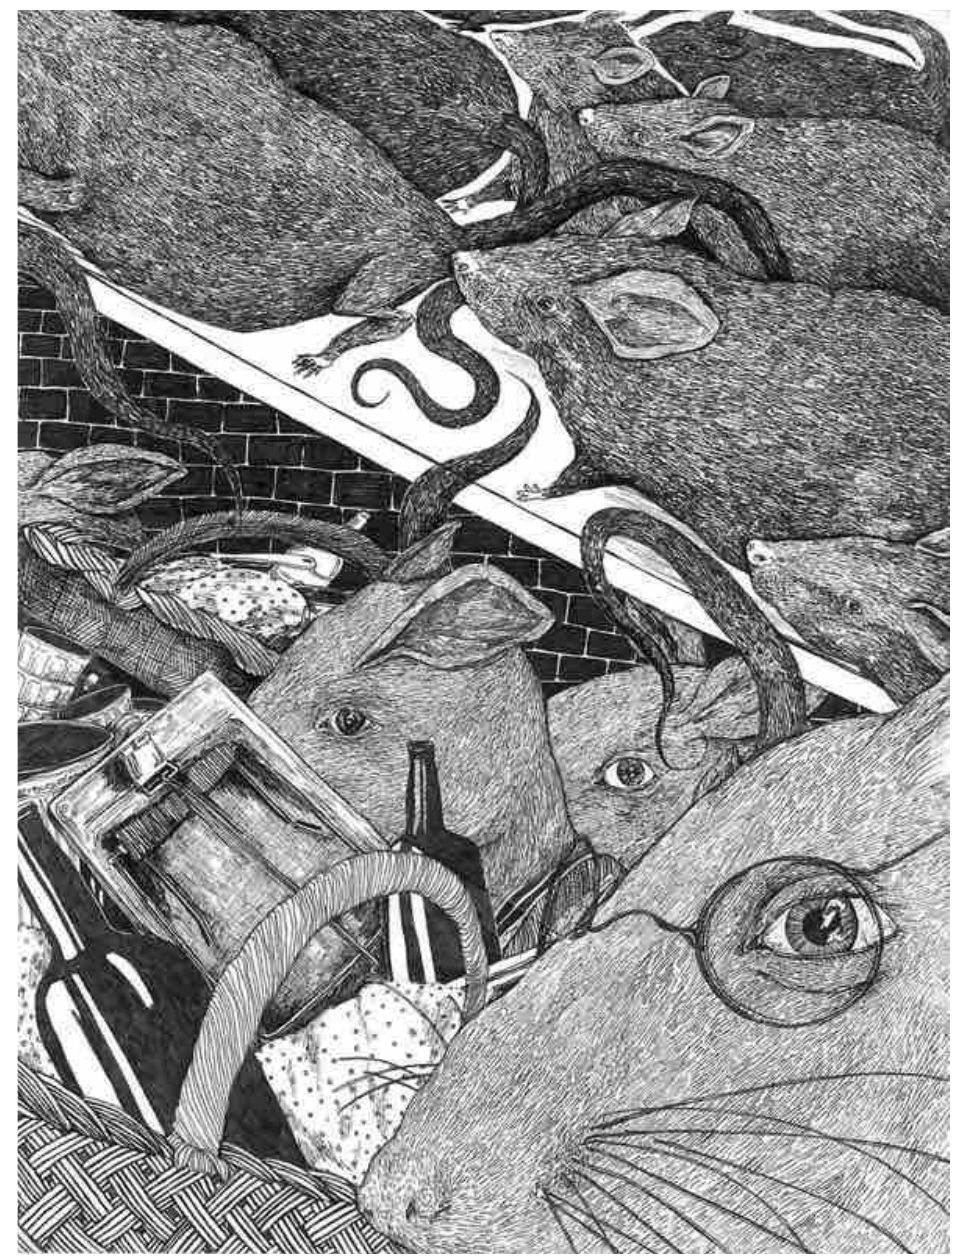
Rosabel Rosalind Kurth-Sofer, Exodus VIII , 2018. Pen and ink on paper. 9x11